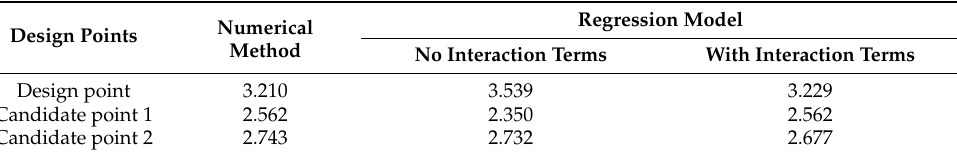
Table 7. Comparison of TPLC prediction between the numerical method and the regression model with design variables.